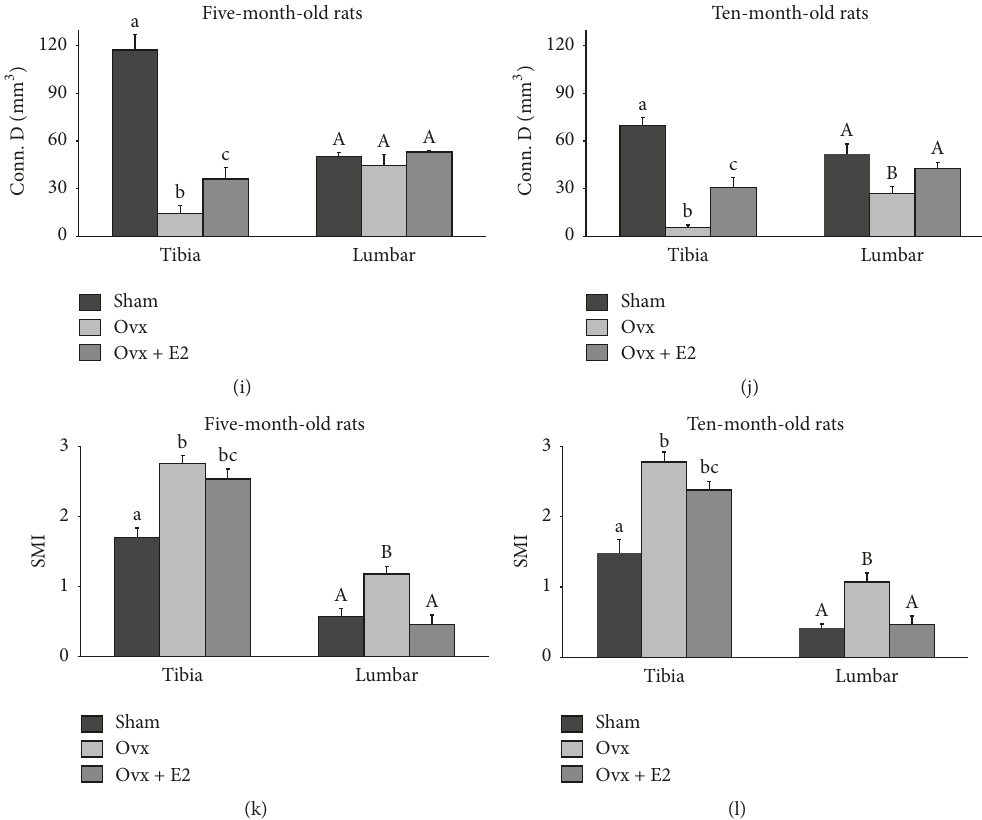
Figure 3: The effects of ovariectomy (ovx) and 17 𝛽 -estradiol (ovx + E 2 ) on BV/TV, bone volume/total volume (a and b); Tb. N, trabecular number (c and d); Tb. Sp., trabecular separation (e and f); Tb. Th., trabecular thickness (g and h); Conn. D, connectivity density (i and j); SMI, structure model index (k and l) of right tibiae and 4th lumbar vertebrae in rats from the cohorts of initial ages of five (a, c, e, g, i, and k) and ten months (b, d, f, h, j, and l). Values are means ± SEM. Bars that do not share the same superscript letters are significantly